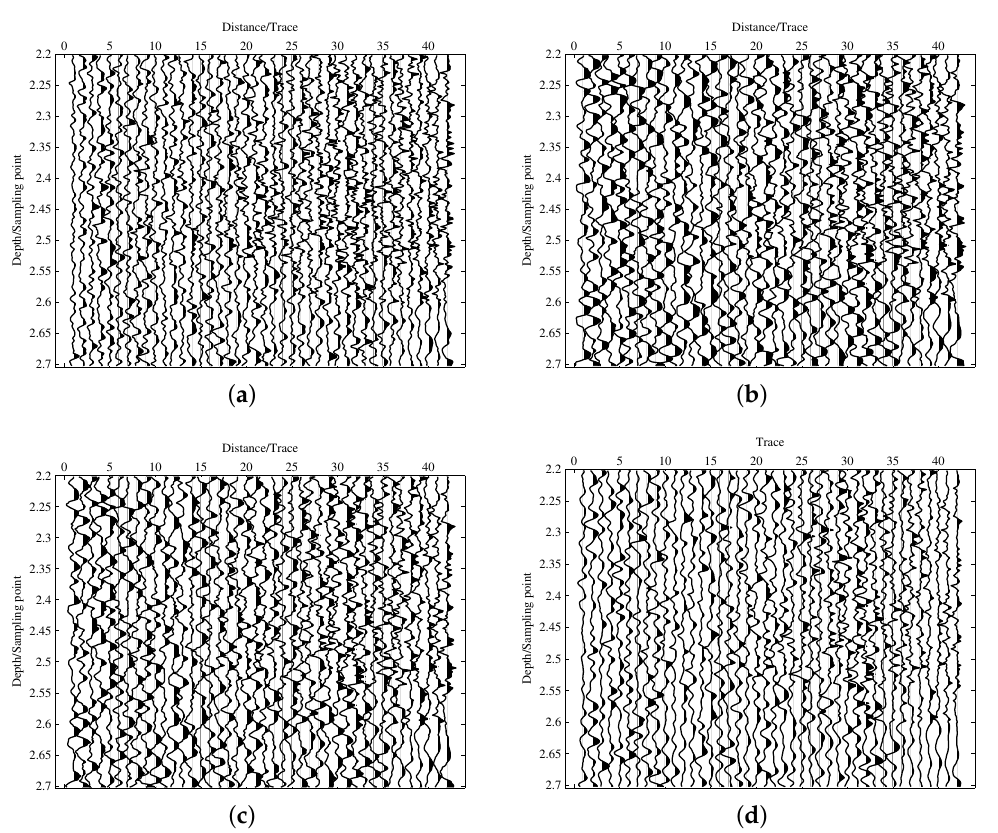
Figure 9. Noise removed by different denoising methods. ( a ) Noise removed by wavelet denoising, ( b ) noise removed by ITVD, ( c ) noise removed by ATVD and ( d ) noise removed by the SD-SpaLR